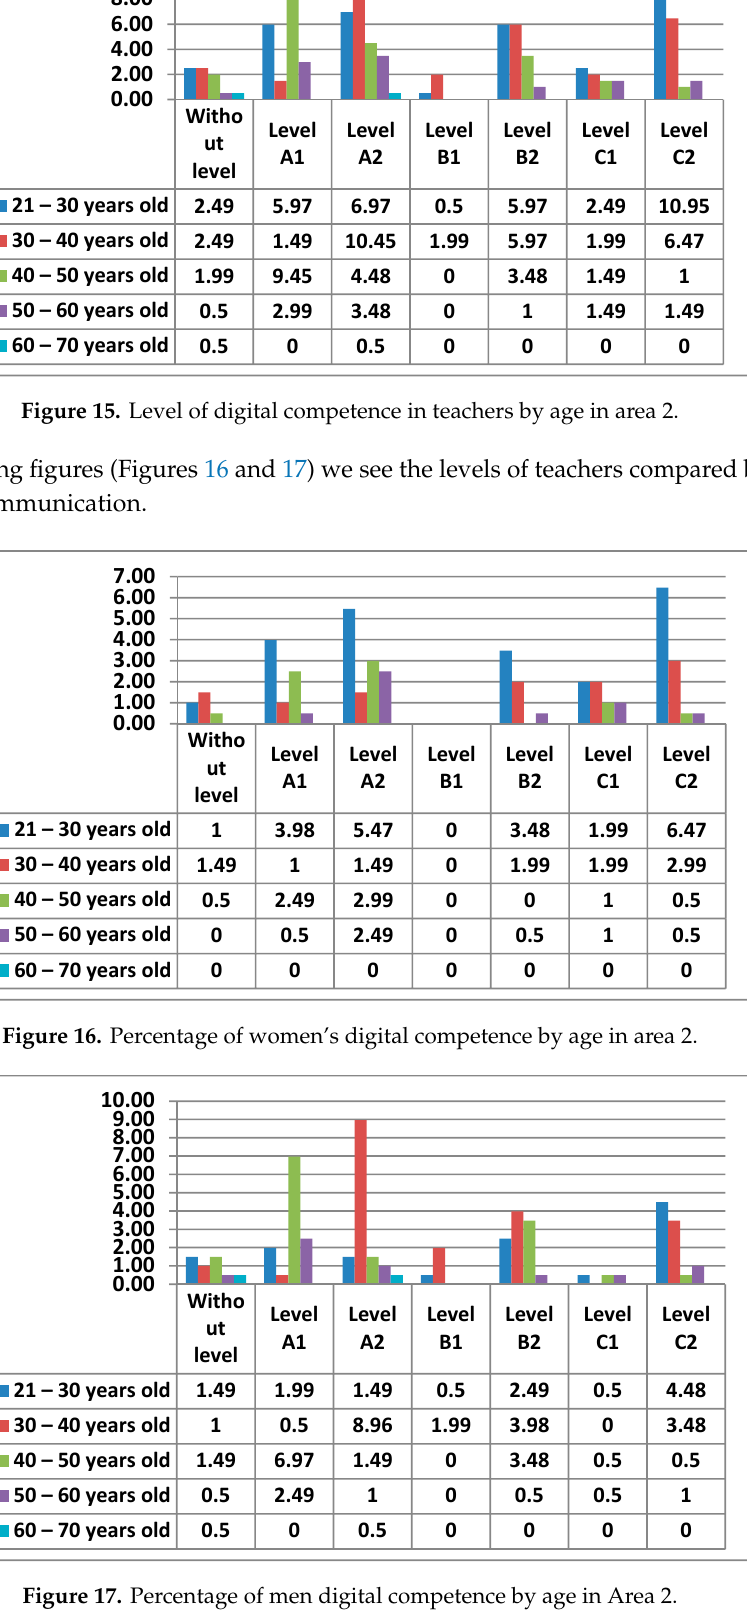
Figure 17. Percentage of men digital competence by age in Area 2.